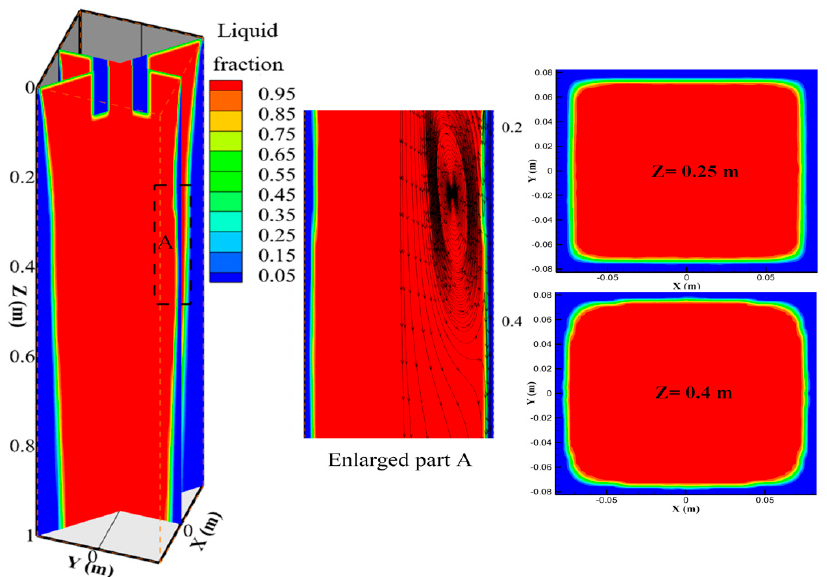
Figure 4. Contour plots of liquid fraction at different sections.